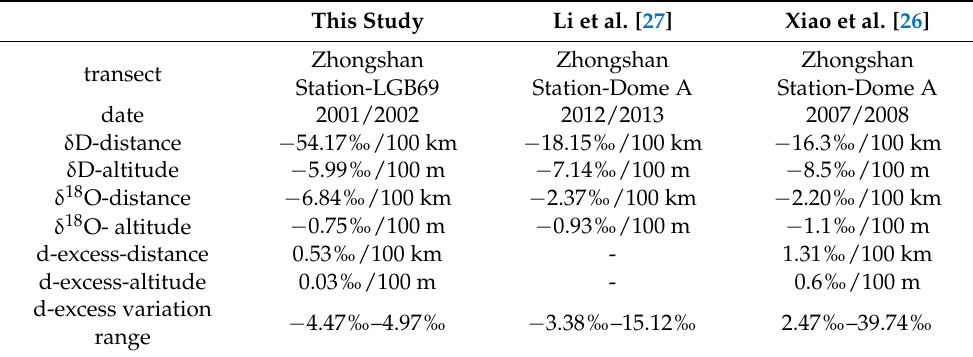
Table 8. Gradients of the stable isotope values with distance from the coast and altitude along the transect from Zhongshan Station to LGB69 or to Dome